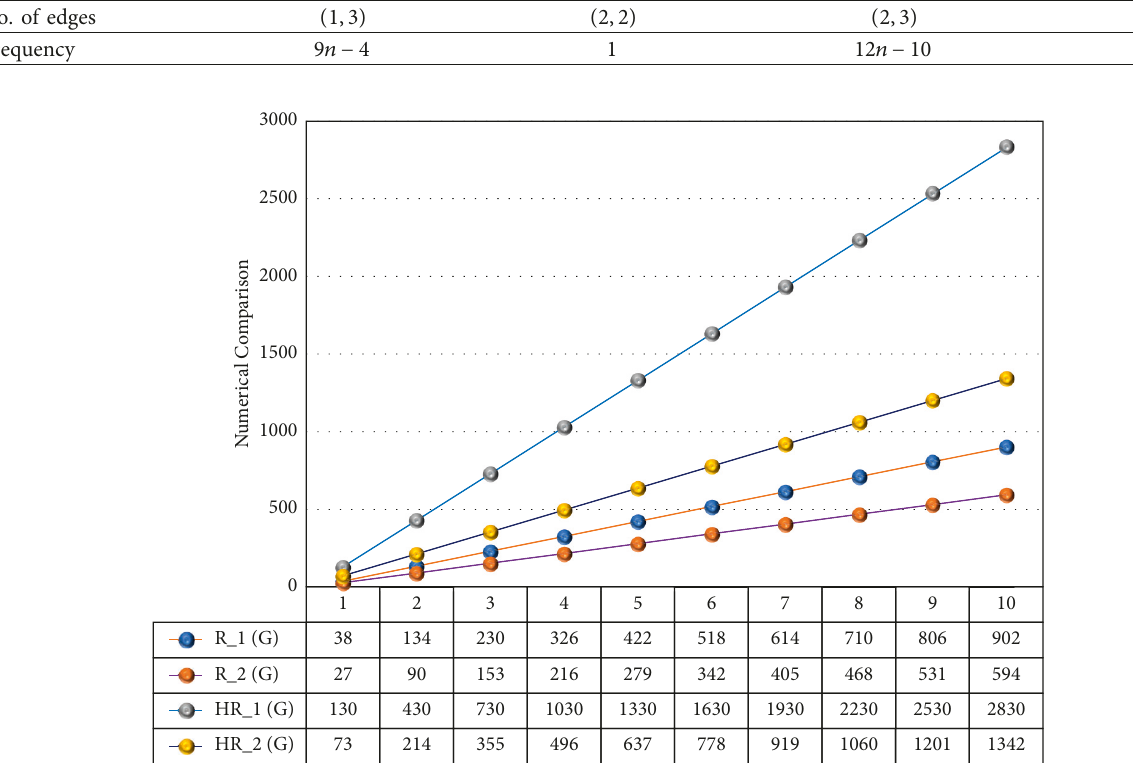
Figure 5: Comparison of R